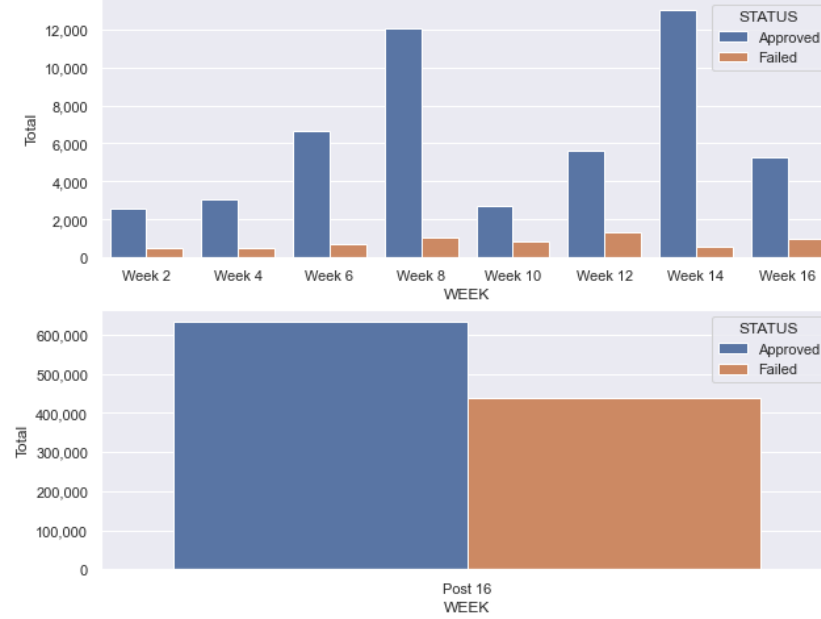
Figure 4. Interactions per weeks approval X